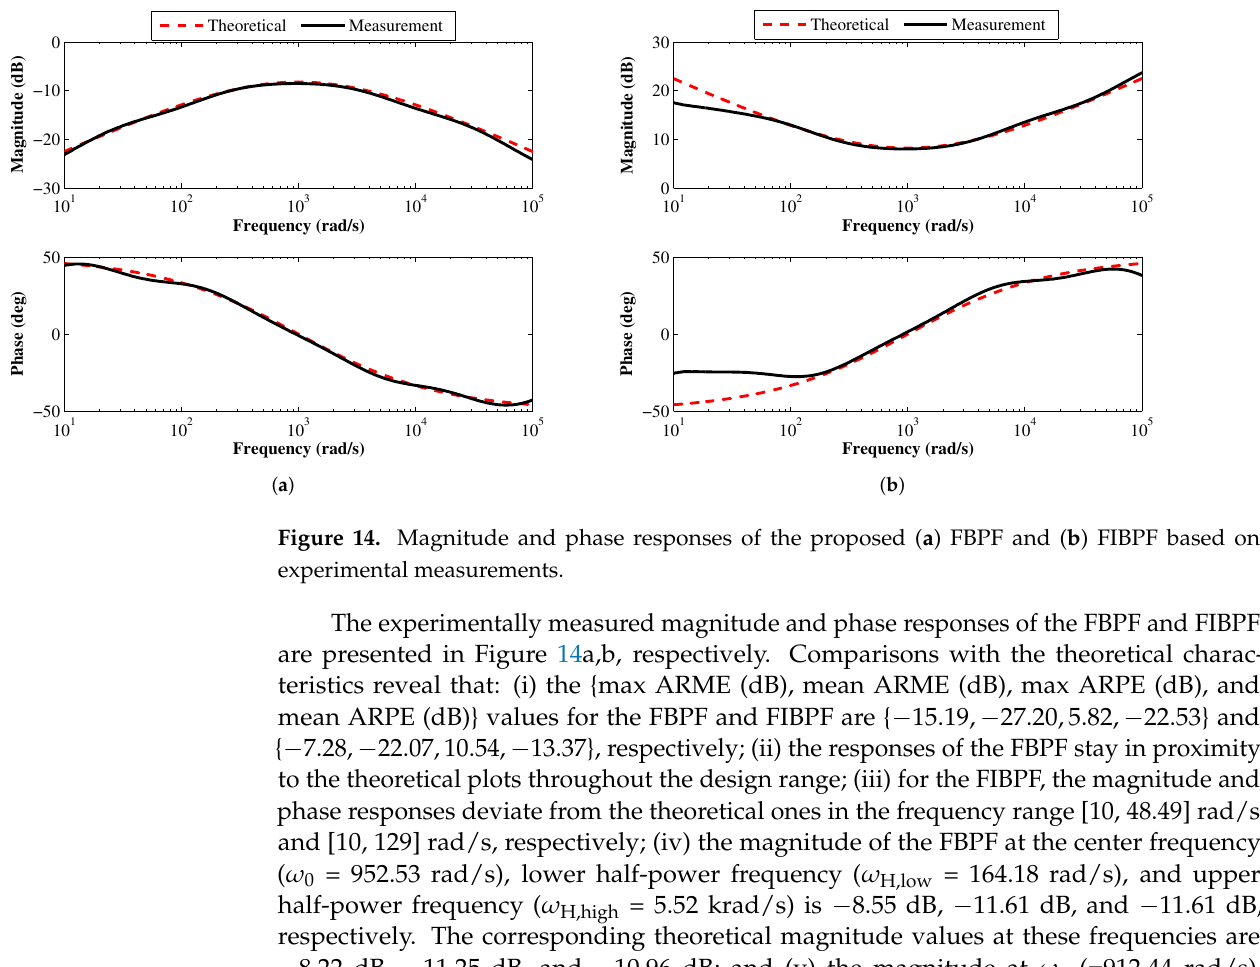
Figure 13. Photograph of the experimental set-up.